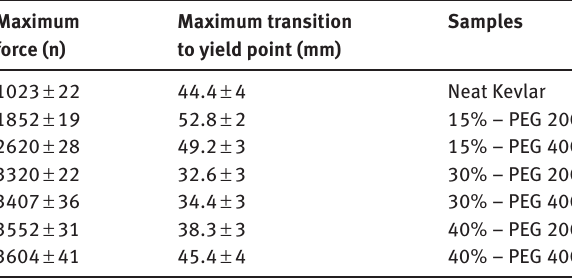
Table 1: Results of the most penetrated force (n), maximum load to yield point (n) and maximum displacement to yield point (mm) for raw samples of 15%, 30% and 40% (PEG 200 and PEG